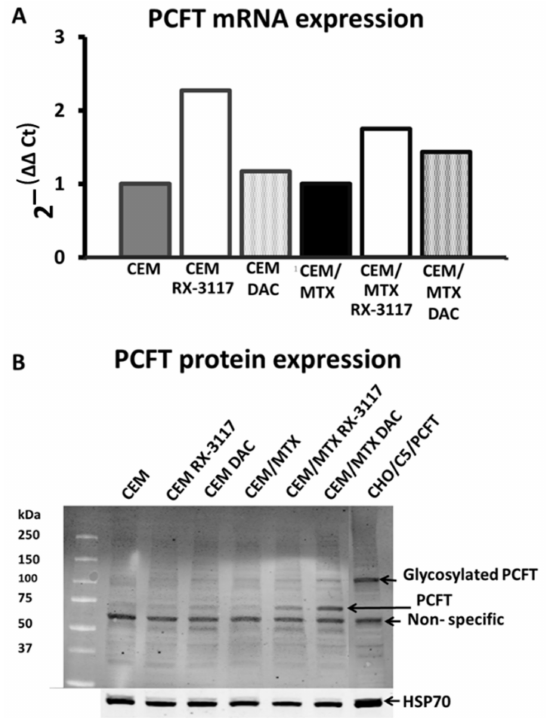
Figure 4. Gene and protein expression of PCFT in CEM and CEM / MTX cell lines after treatment with RX-3117 and DAC. A : RT-PCR data of PCFT gene expression normalized to beta-actin gene expression in CEM or CEM / MTX cells, non-treated, 24 h pre-treatment with 29.6 µ M RX-3117 or 0.19 µ M DAC B : Western blot data of PCFT protein expression in non-treated and after 24 h pre-treatment with 29.6 µ M RX-3117 or 0.19 µ M DAC. Loading control of the membrane compartment is HSP70